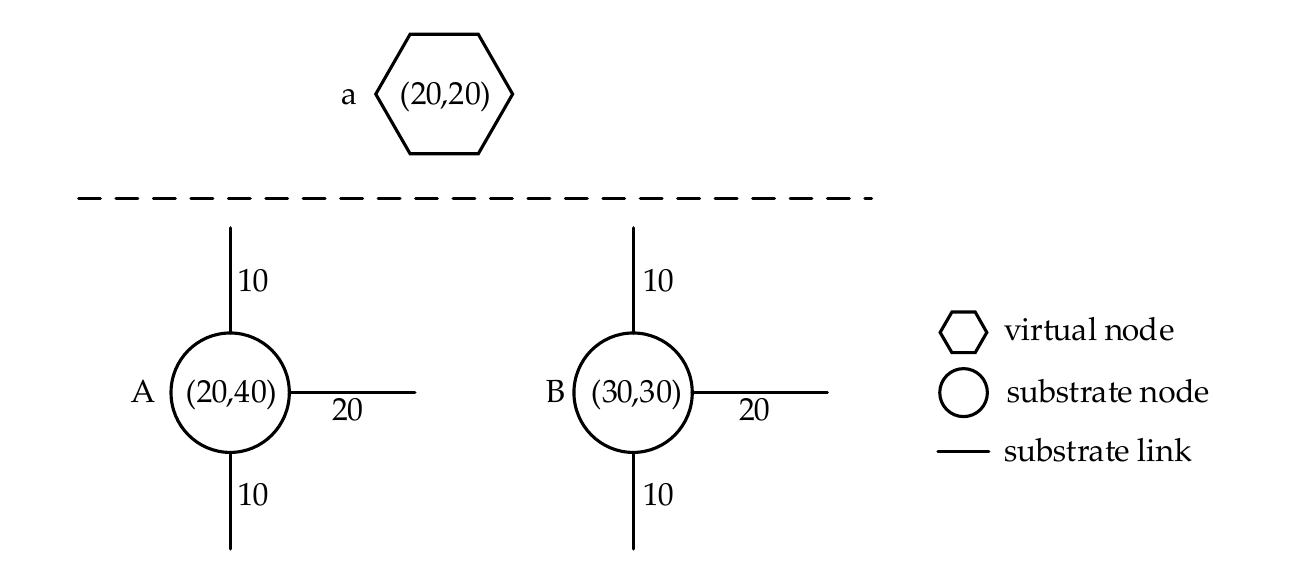
Figure 2. An example of virtual node mapping.